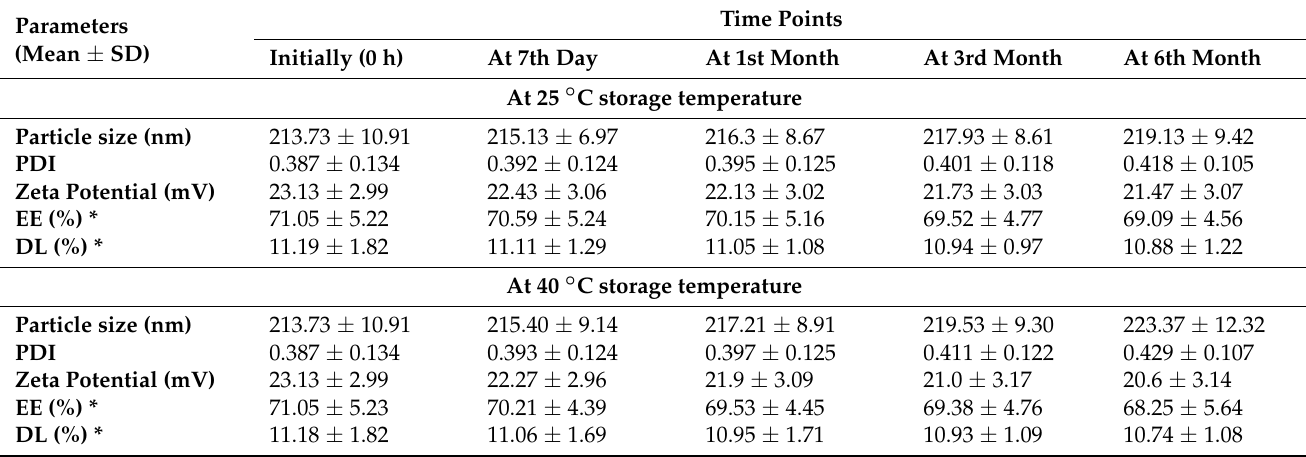
Table 4. Stability study results for LZ–CSNPs stored at 25 ◦ C and 40 ◦ C for six months. Data were presented as the mean of three measurements with standard deviations (Mean ± SD, n = 3).